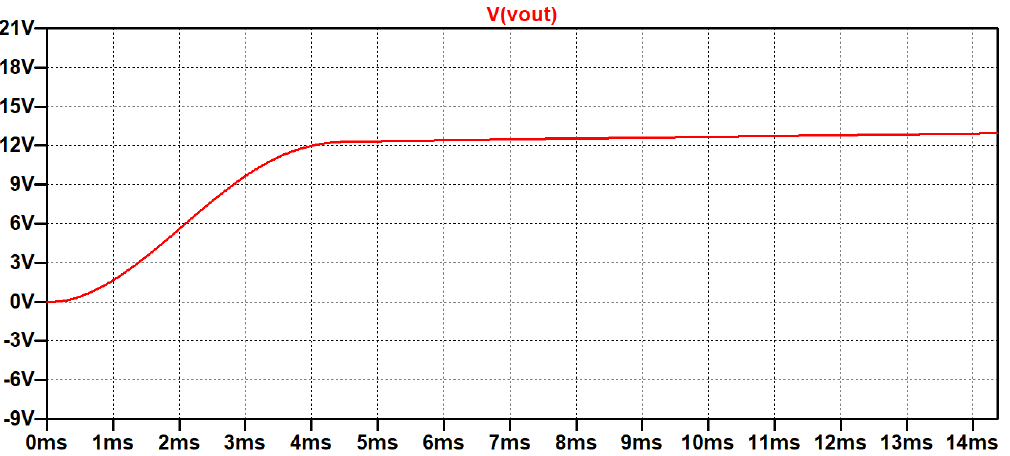
Figure 5. The output voltage response of GaN-FET-based switch for an open-circuit configuration.